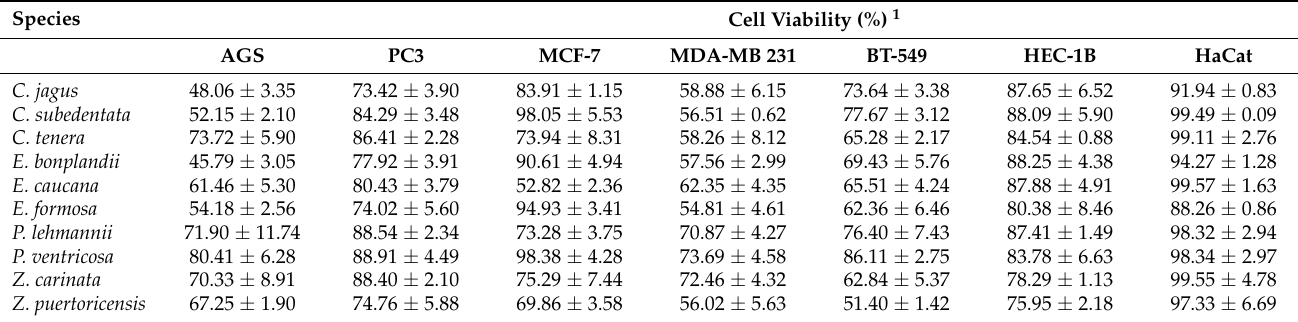
Table 2. Cell viability of alkaloid fractions from Amaryllidaceae